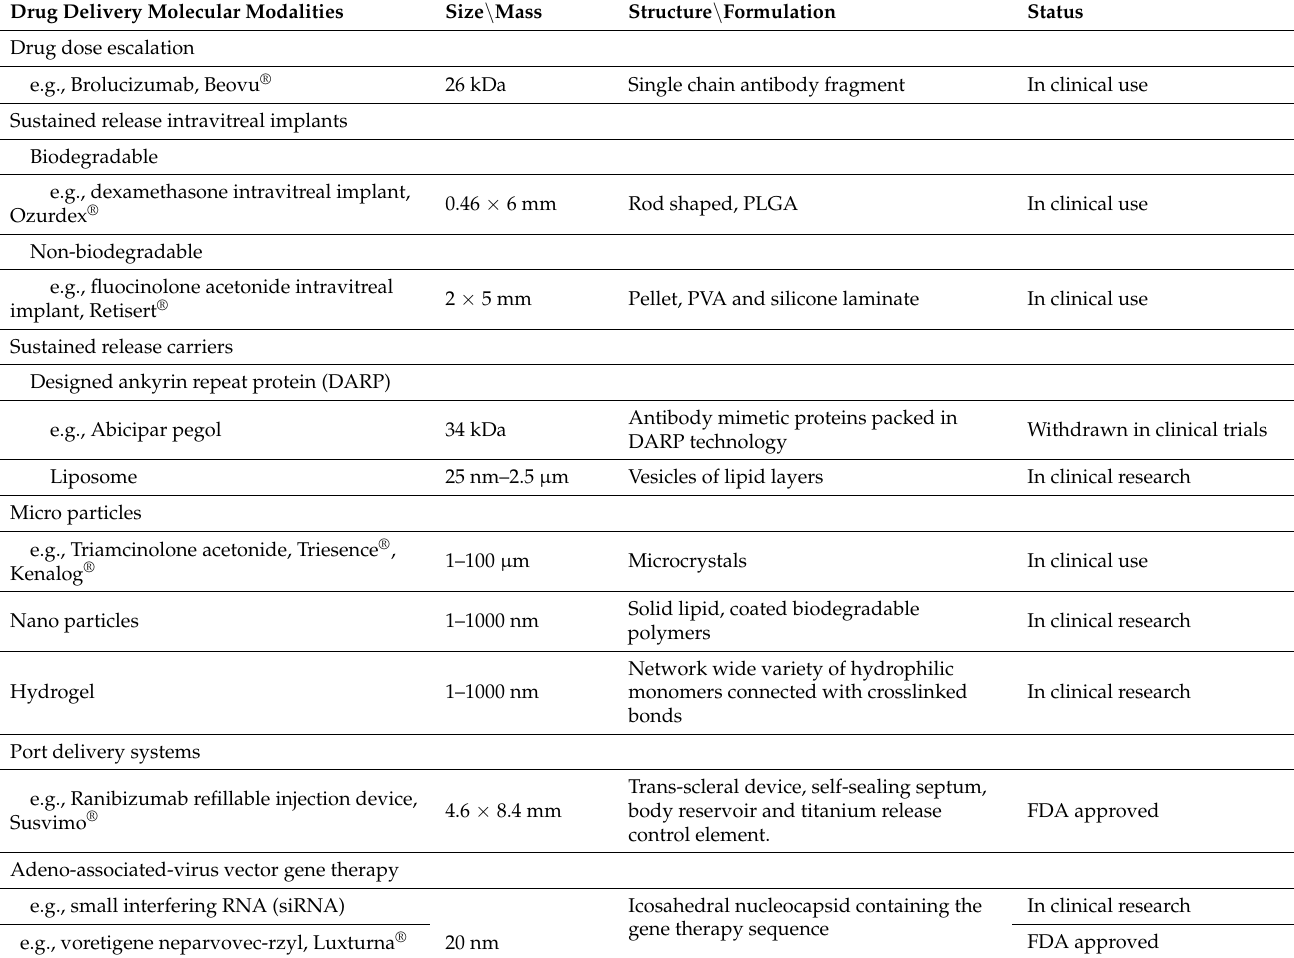
Table 3. Leading drug delivery